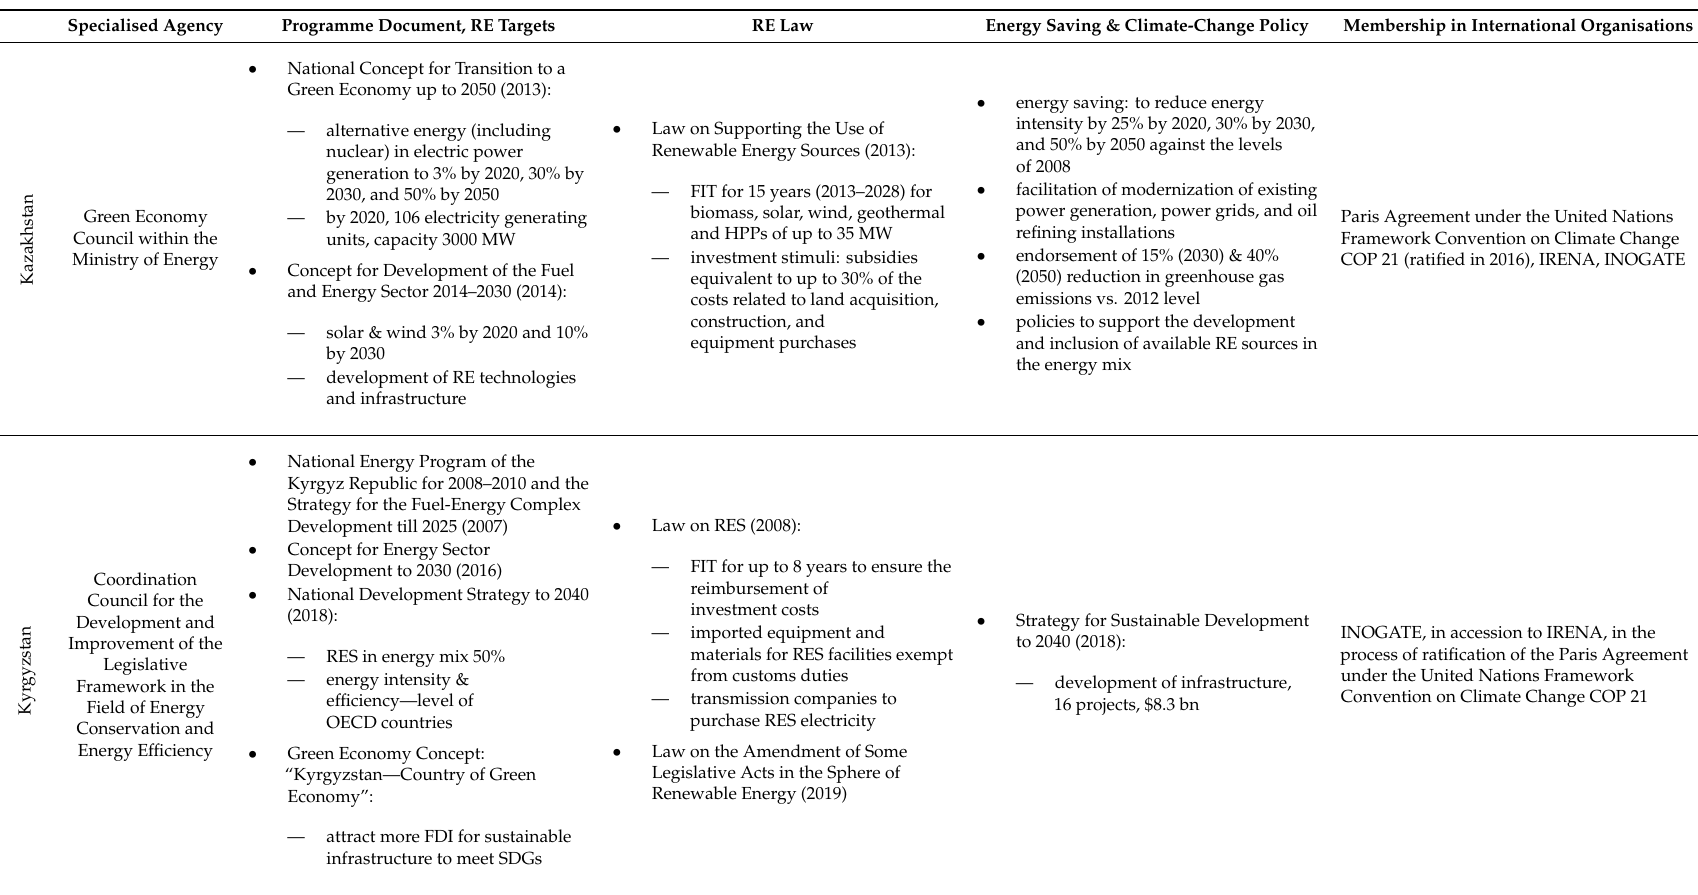
Table A2. Regulation and Political Commitment to RE Development in Central Asian Countries (Source: